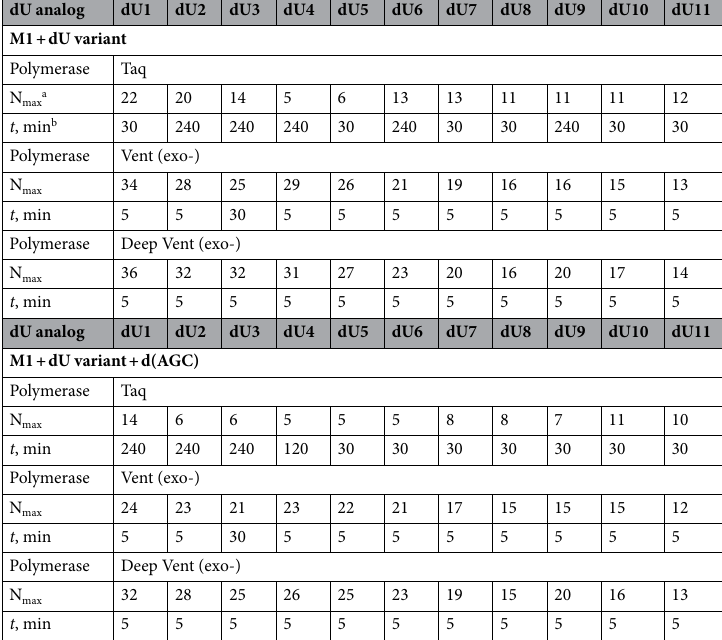
Table 1. Results of the PEX reaction with modified nucleotide substrates. a The maximum number of added residues after 4 h (Taq polymerase) or 3 h (Vent (exo-) and Deep Vent (exo-) polymerases) of the PEX reaction. b The timescale of the standard PEX experiment that yielded products with ≥ 20 added residues or produced the most final products observed at the maximum exposure